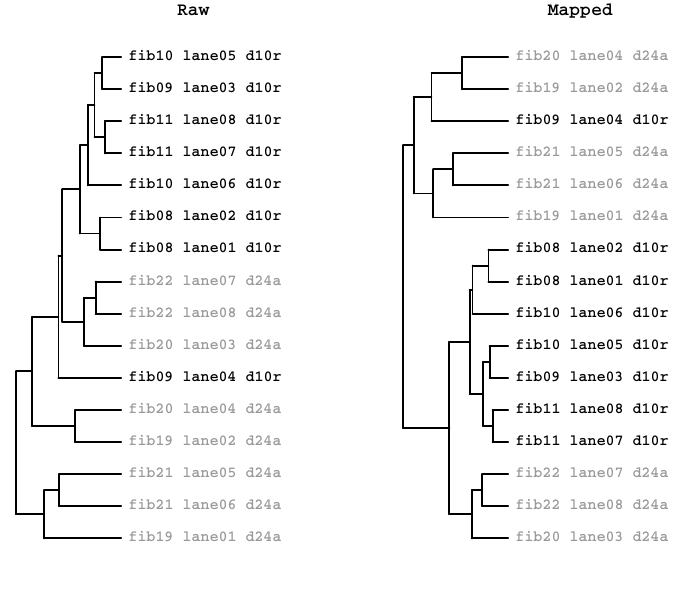
Figure 7. HcKmer on raw and mapped reads: Fastq files containing mapped reads were constructed from raw reads by alignment using TopHat followed by extraction of reads from BAM files using reader2fastq (rbamtools) function. HcKmer on raw and mapped reads was calculated on Fastq files from the same Flowcell pairs. Raw reads consist of unmapped and mapped reads. Left: HcKmer on raw reads. Right: Mapped reads. Leaf labels denote cell type (fib), lane number, and Flowcell label ( d24a and d10r ). All but one samples from Flowcell d10r (dark grey) cluster within a separate sub-tree. Raw and mapped reads show similar clustering